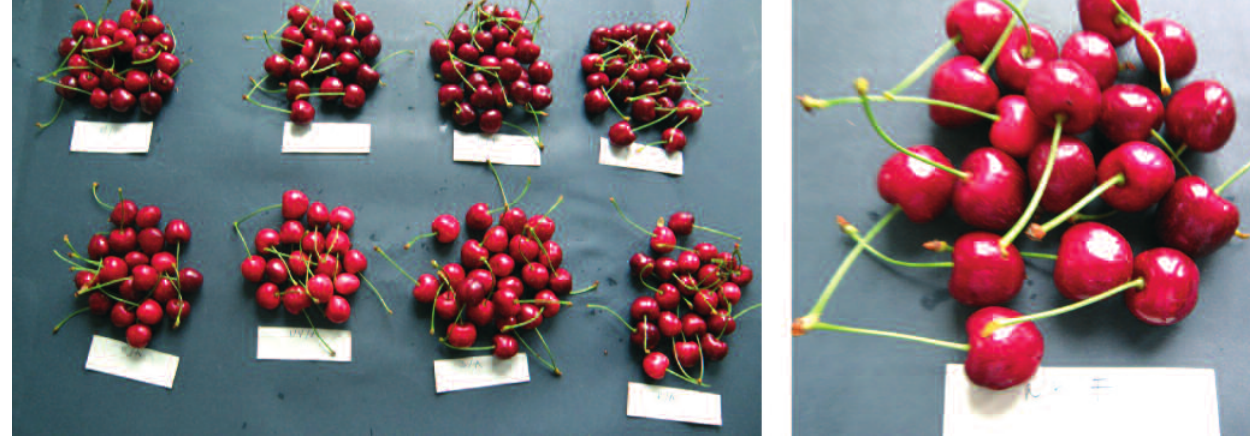
Fig. 1 : Samples of Germersdorfi from 8 different sampling locations Fig. 2: The sample marked as